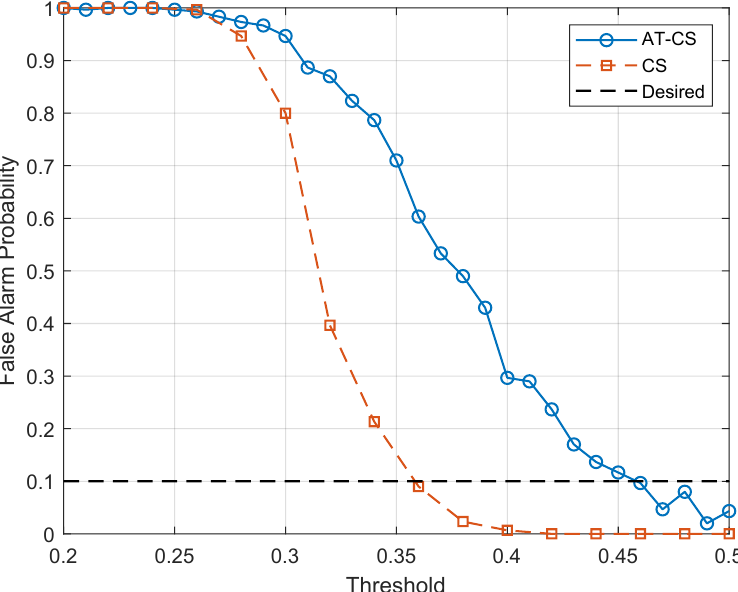
Figure 4. False alarm probability as a function of the detection threshold for the conventional cyclostationary and angle-time cyclostationarity.